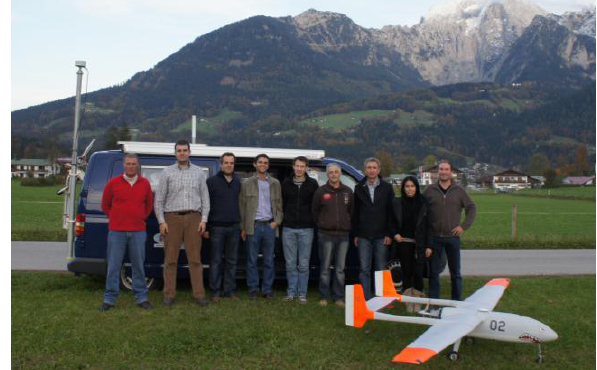
Figure 8. UAV and team involved in the flight trials.